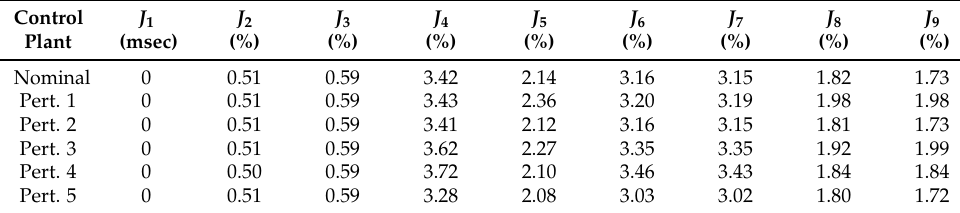
Table A2. Evaluation criteria (Damaged w/ d, Morgan earthquake, Case 4).